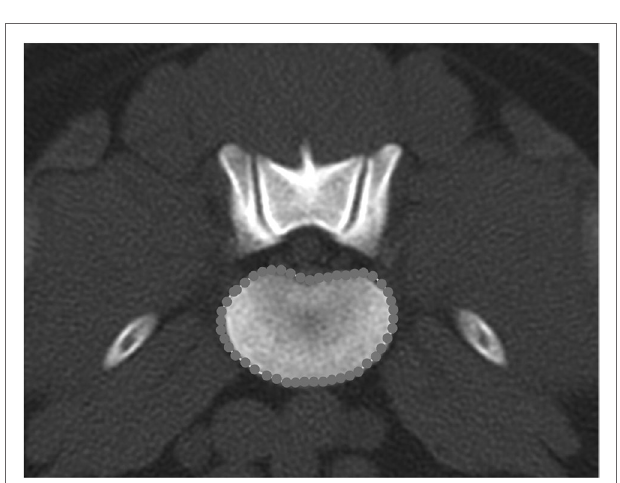
FIGURe 14 | transverse bone window Ct image at the level of L6–7, illustrating the hand-traced region of interest and calculated area value for the vertebral body